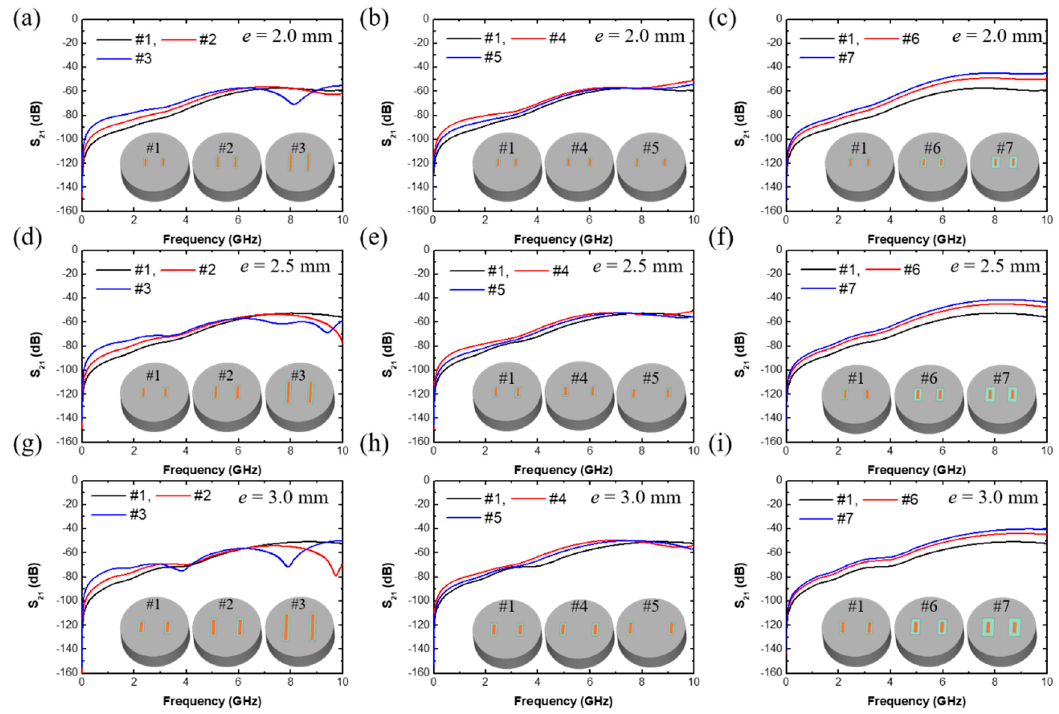
Figure 5. S 21 spectra of the BCP from various ( a , d , g ) antenna widths, ( b , e , h ) antenna distances, and ( c , f , i ) dielectric thickness at various antenna lengths: ( a – c ) e = 2.0 mm, ( d – f ) e = 2.5 mm, and ( g – i ) e = 3.0 mm.